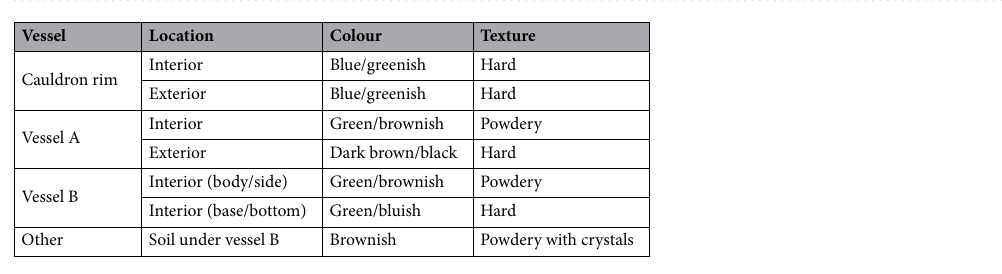
Figure 1. The Pewsey Hoard ( a ) graphic representation of the arrangement of the objects ( b ) the main vessels as delivered to Salisbury Museum ( c ) plant remains found in Vessel B. Source: https:// finds. org. uk/ datab ase/ artef acts/ record/ id/ 720549.